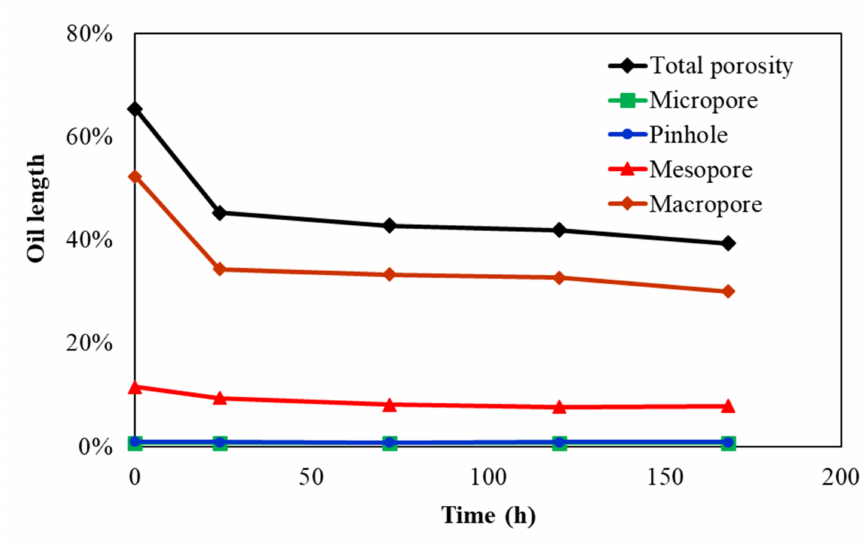
Figure 7. The time-varying curves of oil length in core 1 different levels